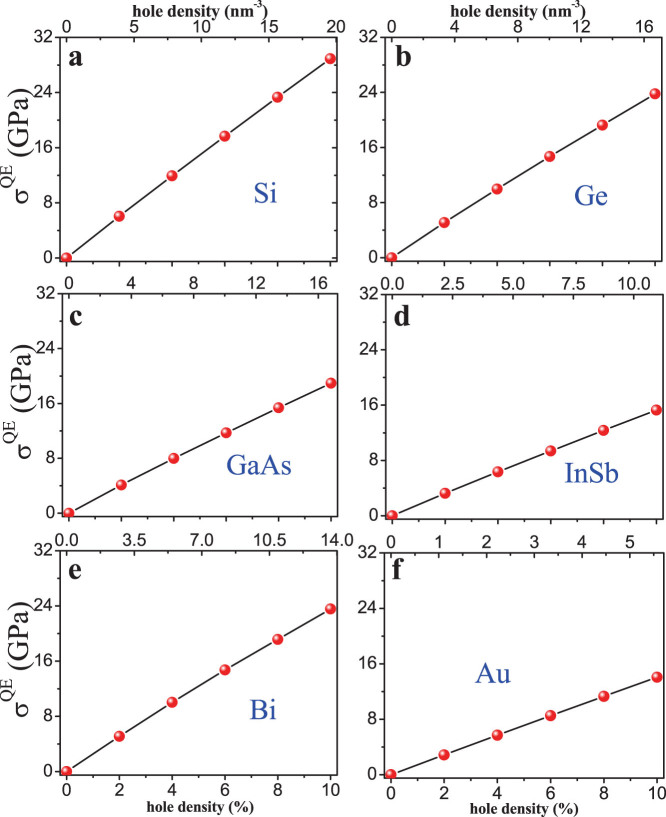
The QES induced by holes in different materials vs. hole density.The bottom x-axis labels the hole density in units of percentage of total valence electrons; the top x-axis in units of nm-3. (a) – (f) are for Si, Ge, GaAs, InSb, Bi and Au, respectively. We consider the outmost sp electrons as valence electron.